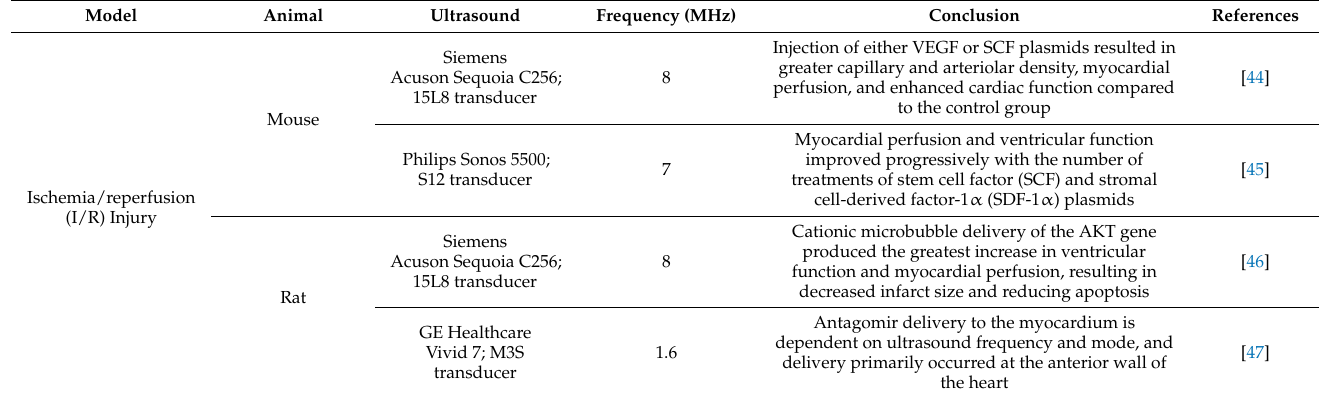
Table 4. The use of sonoporation for cardiac tissue